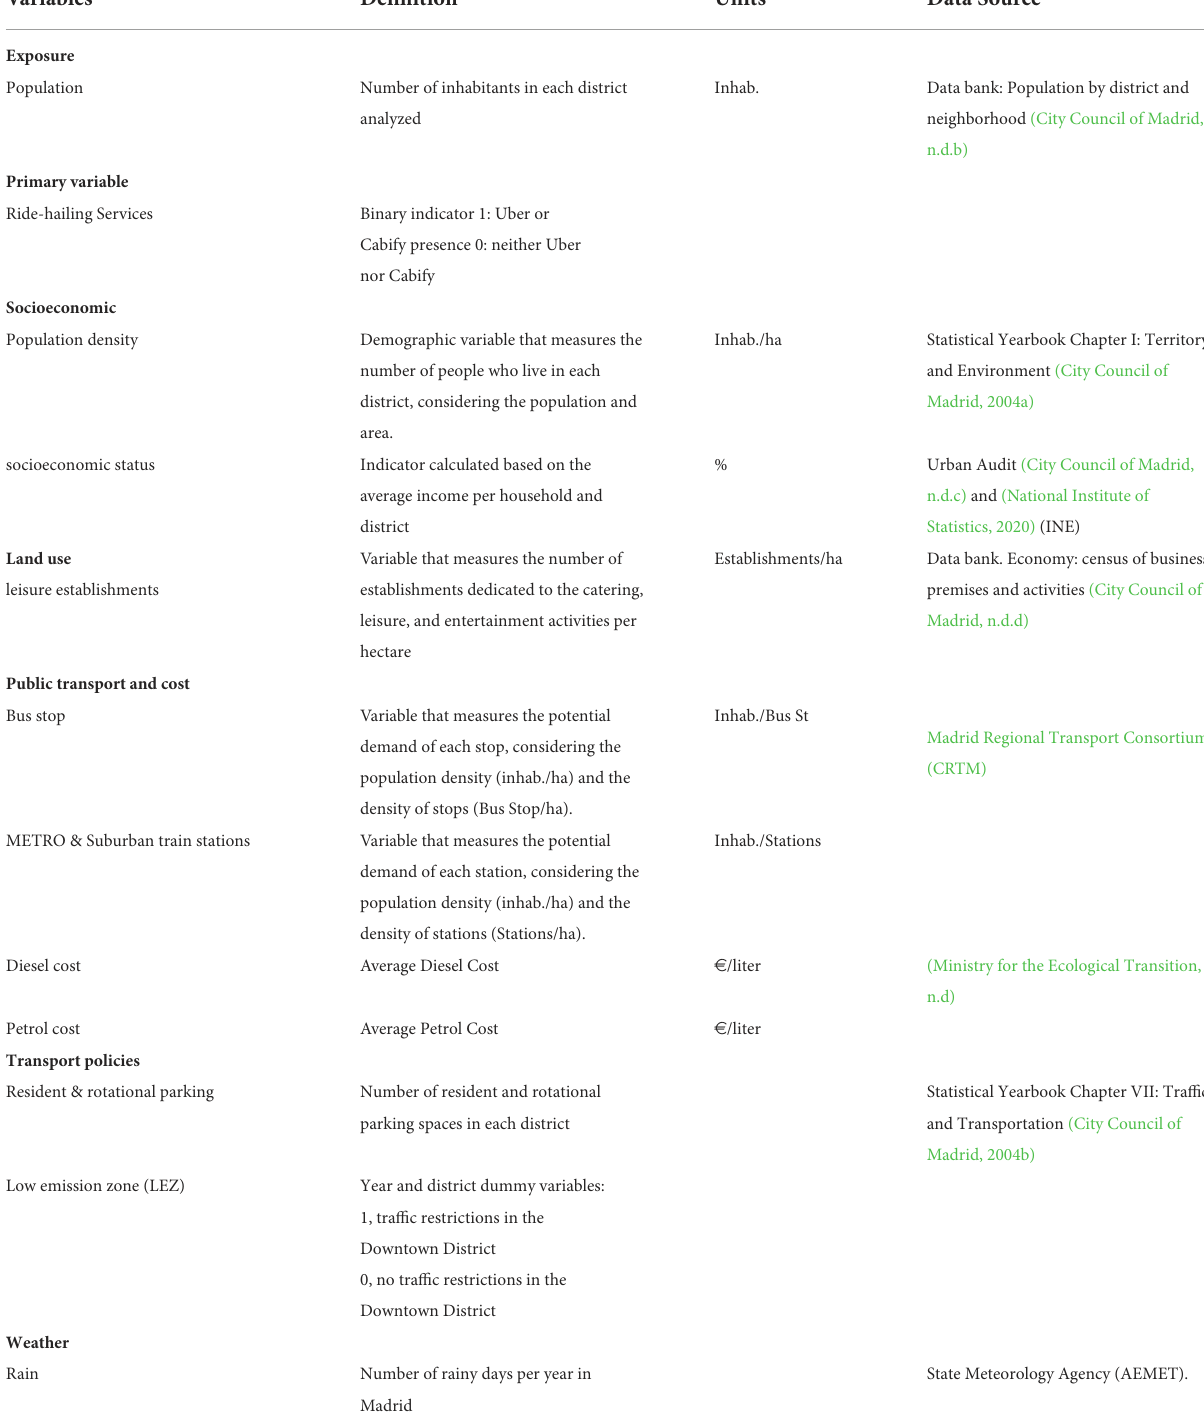
TABLE 1 Variables source: own